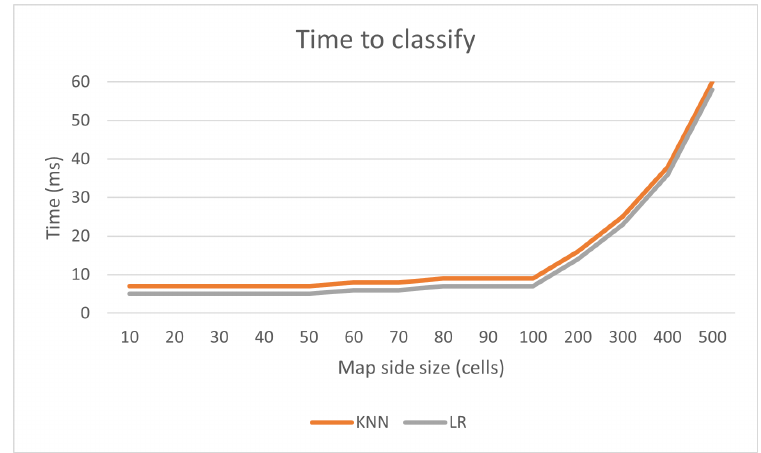
Figure 17. Time required to make an offloading decision.